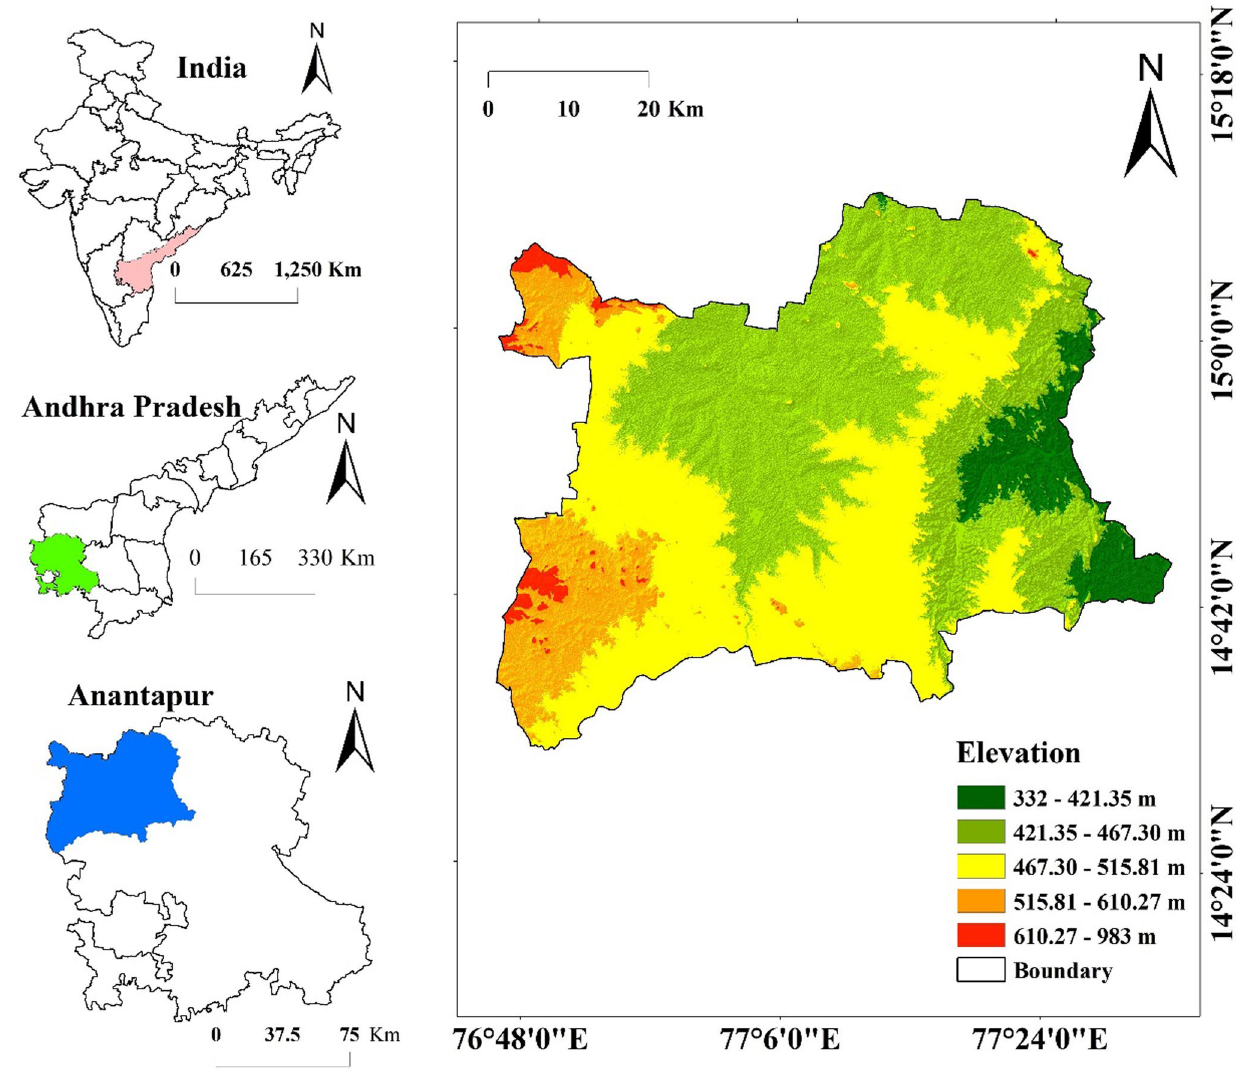
Fig. 1 Study area: north-western part of